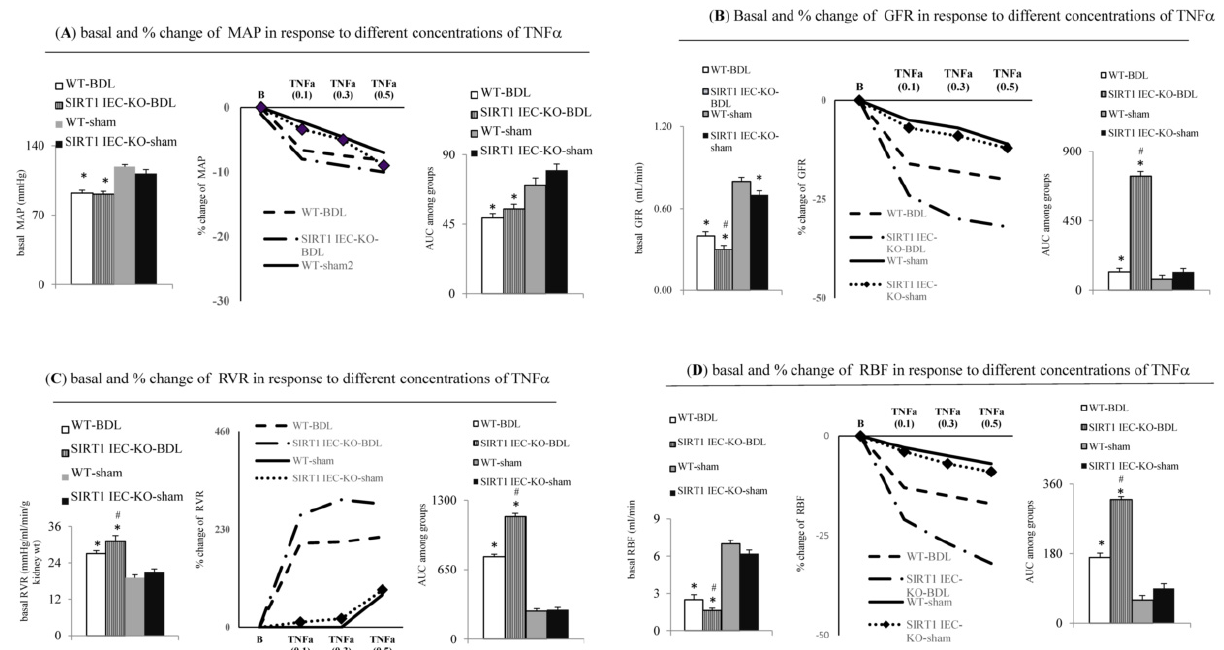
Figure 4. Effect of intestinal SIRT1 deficiency on systemic and renal vascular response to cumulative doses of TNF α cirrhotic ascitic mice. Graphs and area under curve (AUC) of concentration-response curve of TNF α induced a decrease in ( A ) the MAP, ( B ) the GFR; ( C ) the increase in the RVR and ( D ) the RBF during in situ renal perfusions among groups. * vs. WT-sham mice; # vs. WT-BDL mice.